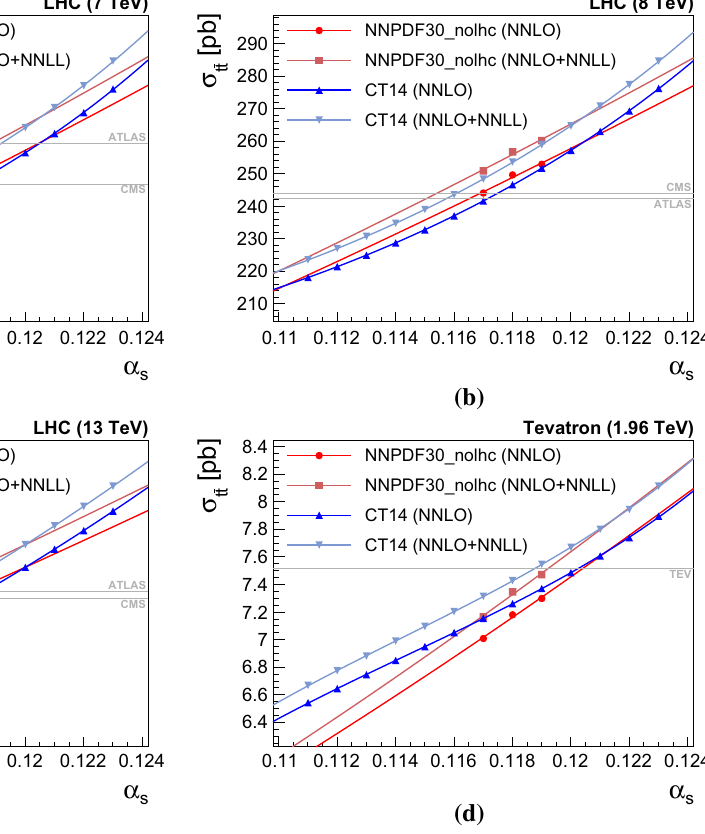
corresponding to the central values of the measured cross sections, adjusted to correspond to the same top mass as the theory cross sections ( m t = m ref t = 173 . 2GeV), cf. Sect.